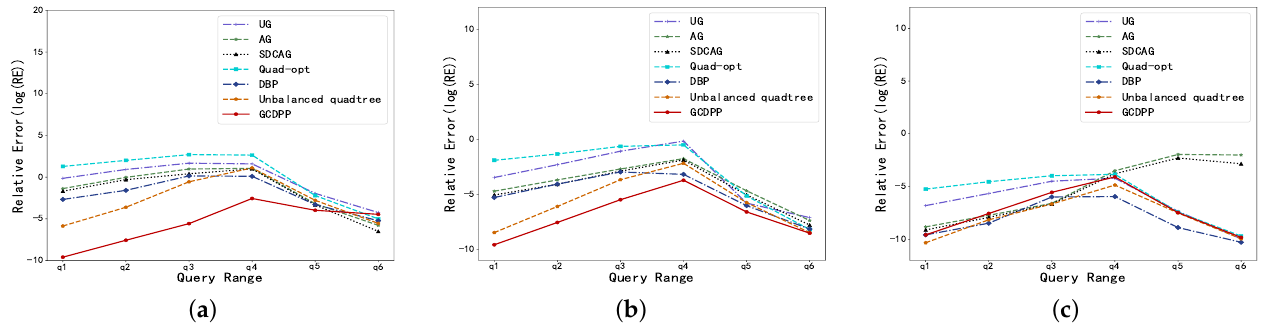
Figure 12. Comparison of querying accuracy on Landmark dataset. ( a ) Landmark dataset, (cid:101) = 0.01; ( b ) Landmark dataset, (cid:101) = 0.1; ( c ) Landmark dataset, (cid:101) = 1.